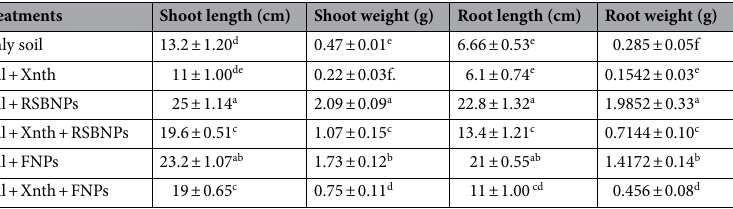
Table 3. Effect of rice straw biochar nanoparticles (RSBNPs) and fly ash nanoparticles (FNPs) and Xanthomonas campestris pv . vesicatoria inoculation on chili plant growth parameters including shoot length, root length as well as root and shoot weights. Data represent mean values ± standard error and abcd denote significance